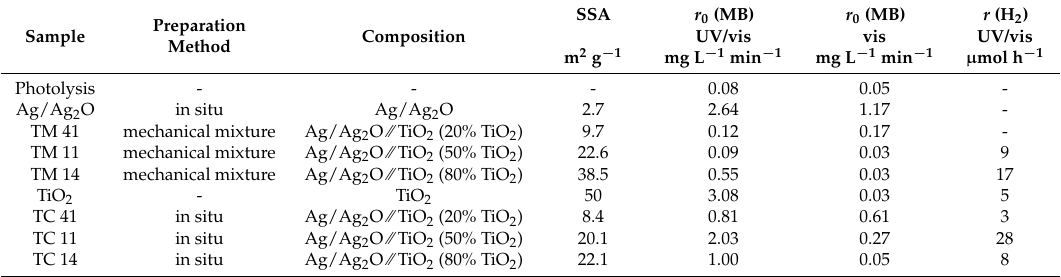
and H 2 generation in the presence of Ag/Ag 2 O, TiO 2 , the TM mixtures and the TC composites.